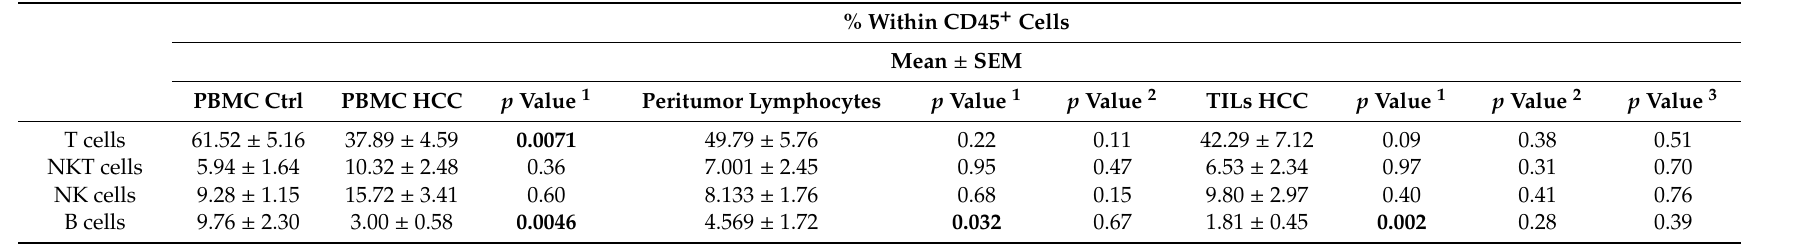
Table 1. Total lymphocyte and NK subsets.